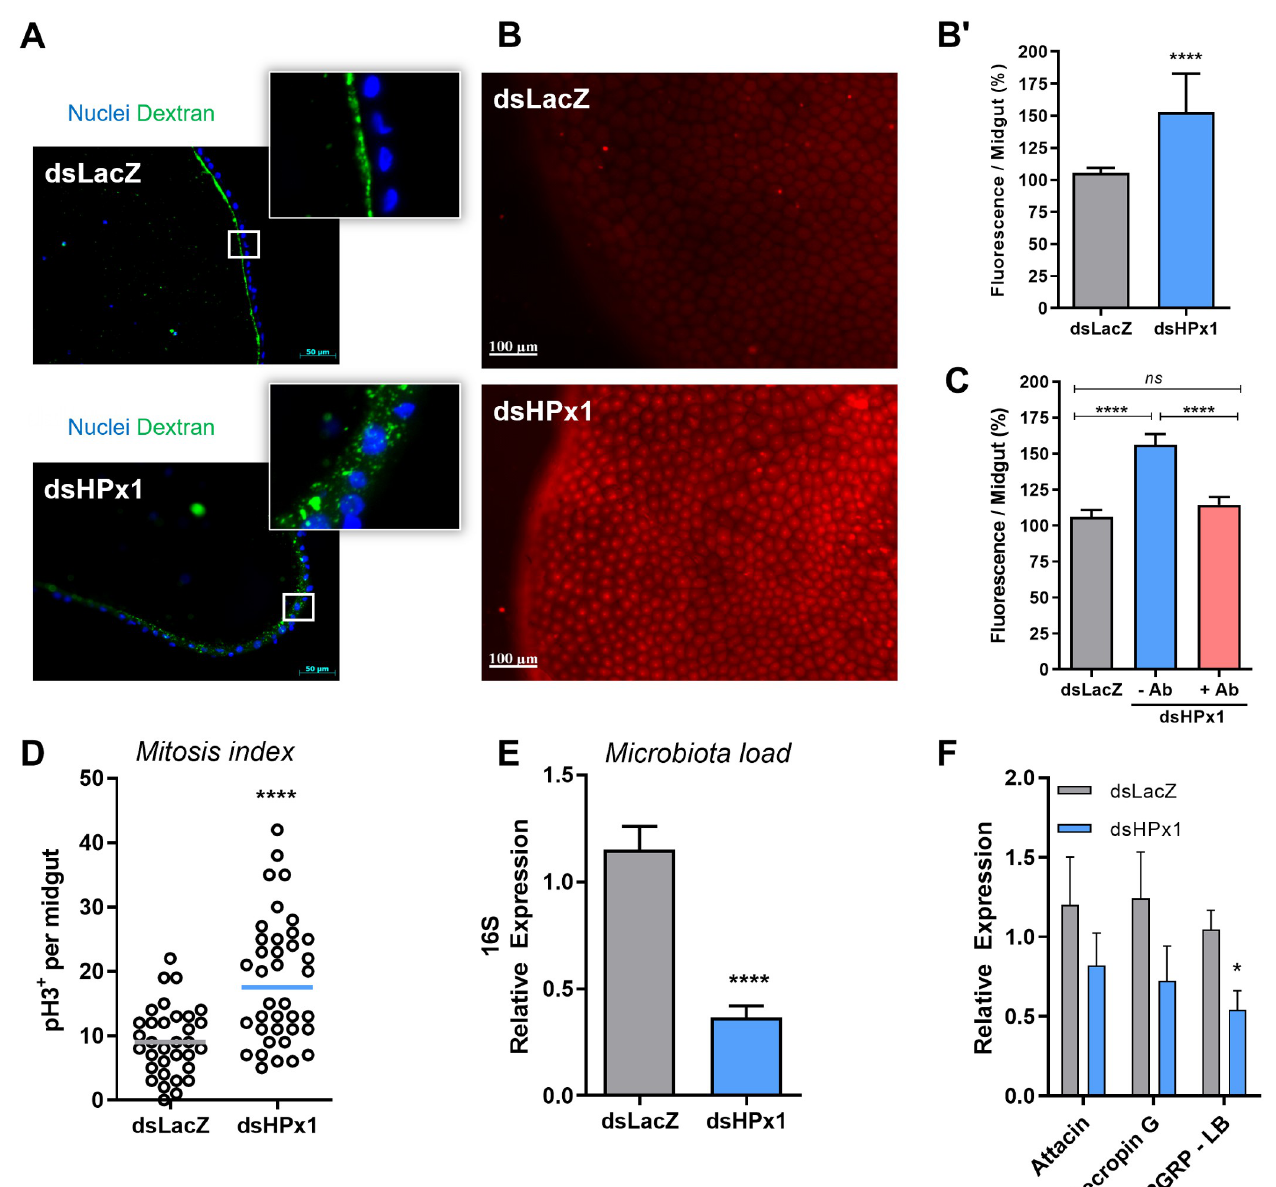
Fig 3. The role of HPx1 in PM assembly. A) Midgut transverse slices at 18 h ABM supplemented with dextran. Green: dextran—FITC. Blue: DAPI nuclear staining. Insets highlight dextran localization. B) Representative images of ROS levels measured by DHE oxidation in individual midguts at 18 h ABM. B’) Quantitative analysis of the fluorescence intensity of oxidized DHE (dsLacZ, n = 35; dsHPx1, n = 39). C) Quantitative analysis of the fluorescence intensity of oxidized DHE from individual midguts at 18 h ABM (dsLacZ, n = 32; dsHPx1—Ab, n = 34; dsHPx1 + Ab, n = 27). D) Mitosis index in the mosquito midgut at 18 h ABM (phospho-histone H3) (dsLacZ n = 33; dsHPx1 n = 38). E) The intestinal microbiota load analyzed through eubacterial ribosomal 16S gene expression by qPCR at 24 h ABM (dsLacZ n = 6; dsHPx1 n = 7). F) Immune-related gene expression upon HPx1 silencing at 24 h ABM by qPCR (dsLacZ n = 8; dsHPx1 n = 7). � p < 0.05, ���� p < 0.0001, ns = not significant. Data are the mean +/- SEM. The T test for B’, D, E and F, and one-way ANOVA with Tukey’s posttest for